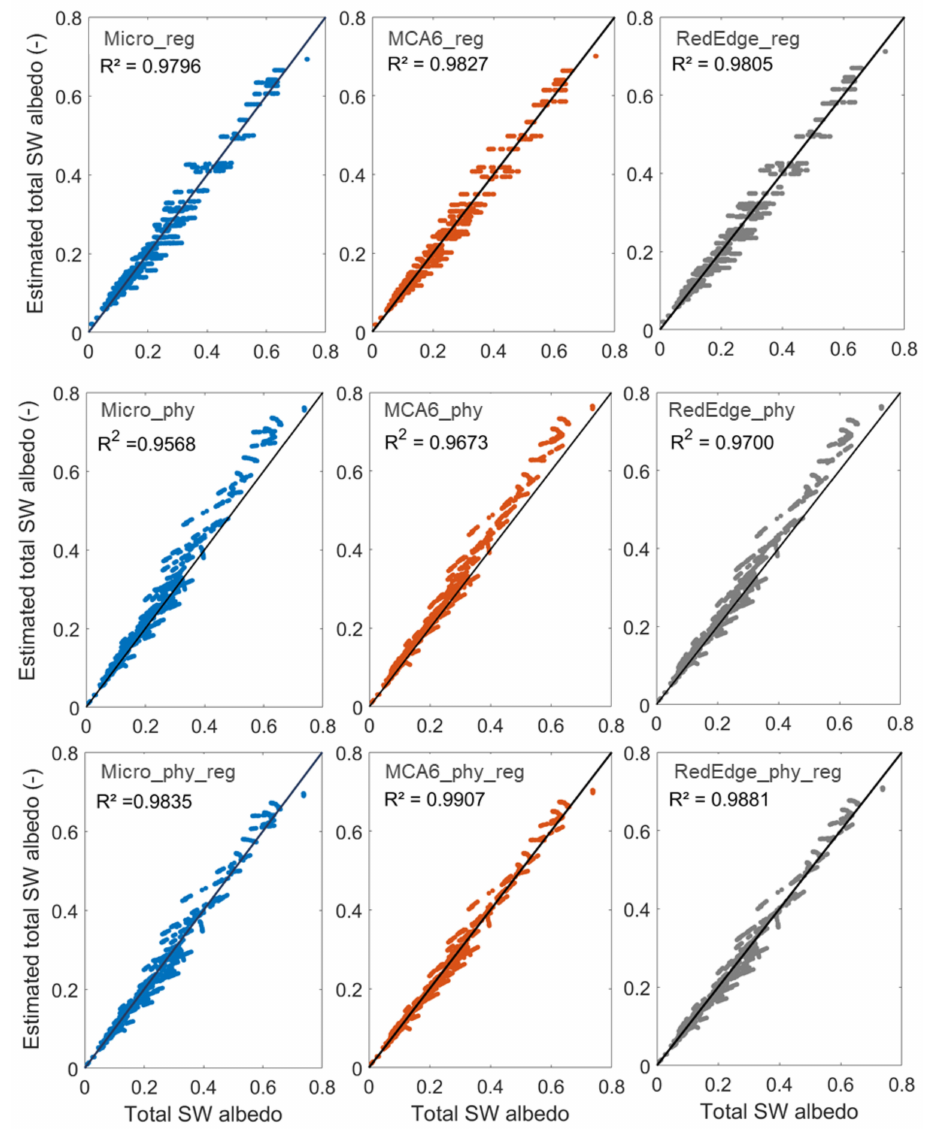
Figure 4. ASD measurement-based simulated total SW albedo (horizontal axis) and estimated values (vertical axis) retrieved by narrowband albedos of ADC-Micro (first column), MCA6 (second column), and RedEdge (third column) applying Model_reg (first row), Model_phy (second row), and Model_phy_reg (third